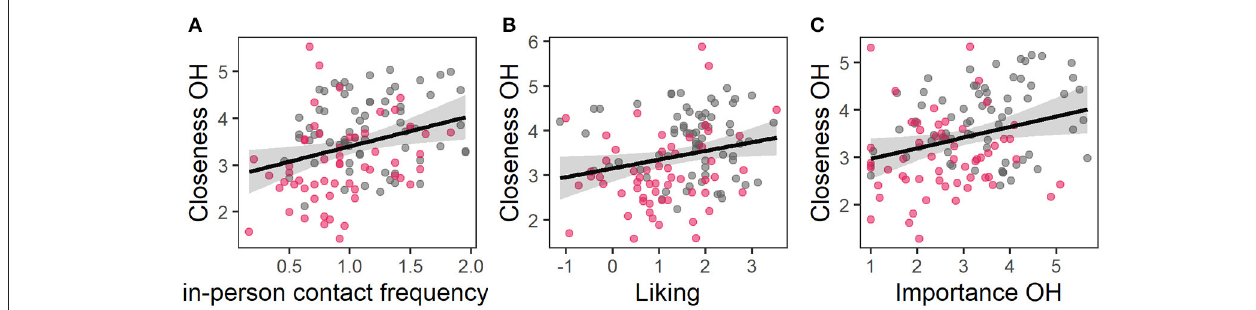
FIGURE 3 | Partial residual plots of regression model 1; the observed data is based on the values of (A) in-person contact frequency, (B) liking, and (C) importance of touch and the model error. The grey area represents the confidence interval, grey dots data of HC and red dots data of BPD.